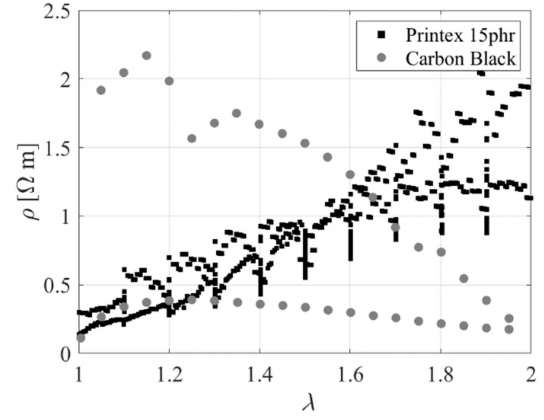
Figure 33. Resistivity as a function of the extension ratio for carbon black − and Printex 15 phr − filled